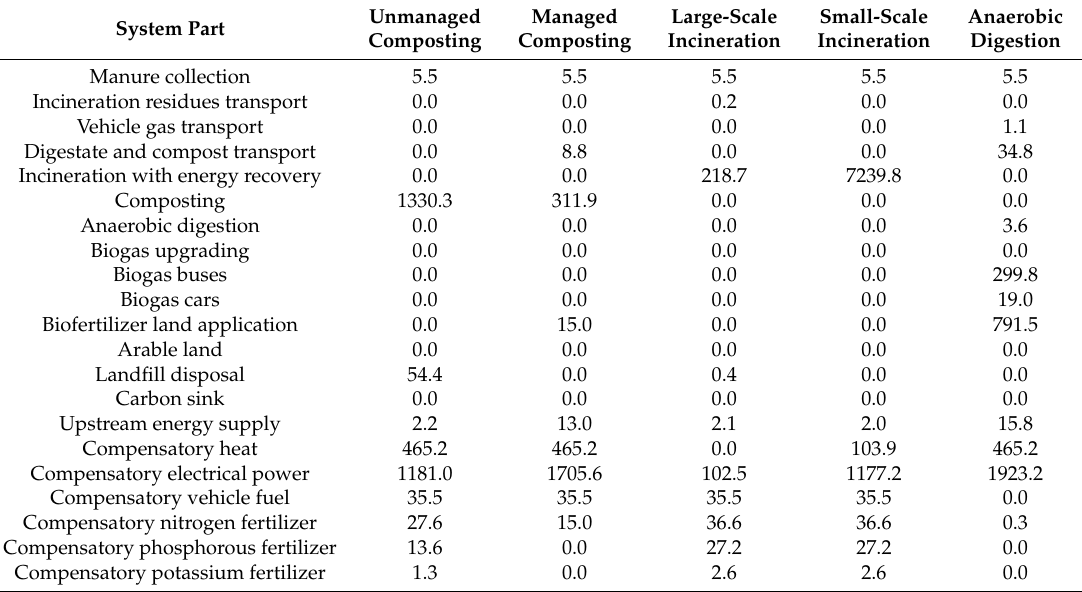
Table B3. Acidification Potential (kg SO 2 -eq.).